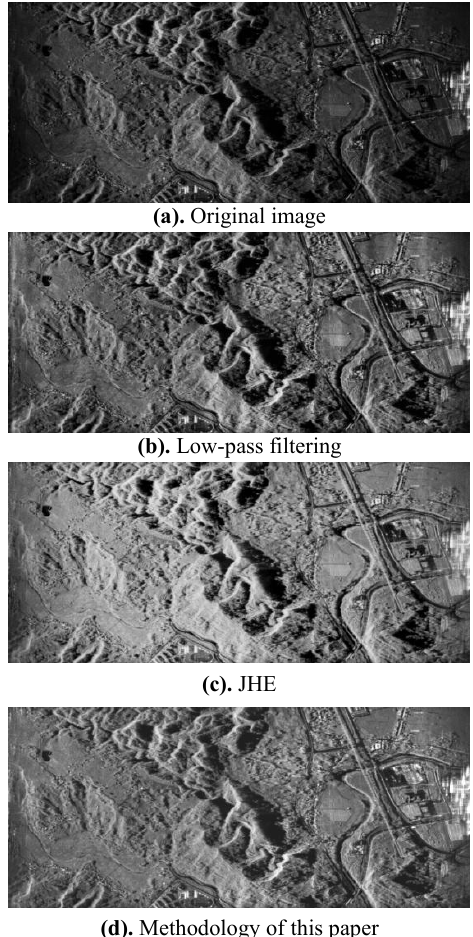
Figure 2. HH-polarized SAR images of the Ya'an area